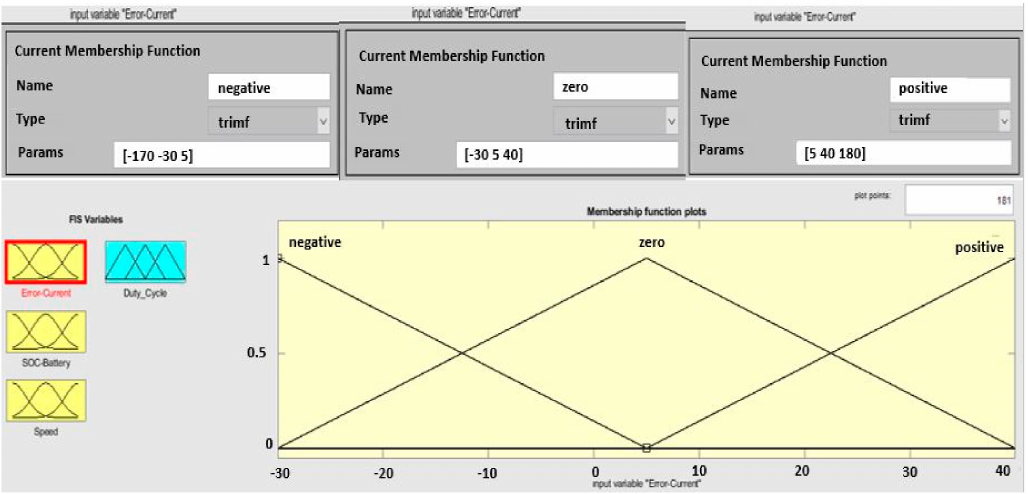
Figure 8. Membership functions of error current.